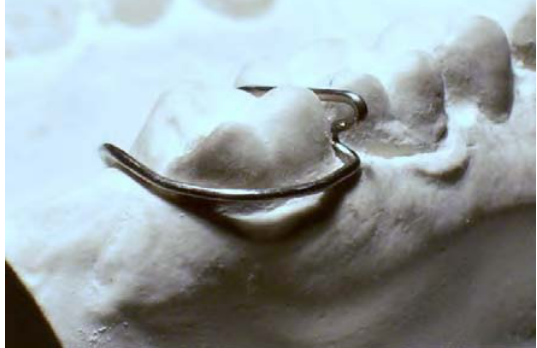
Fig. Adam’s clasp with single arrowhead